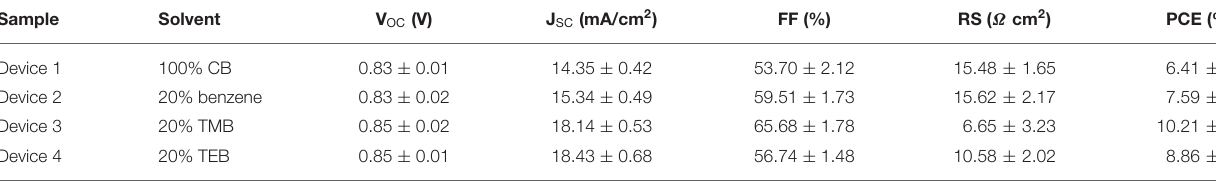
TABLE 1 | Performance of devices prepared by ultrasonic spray using varied solvents. Sample